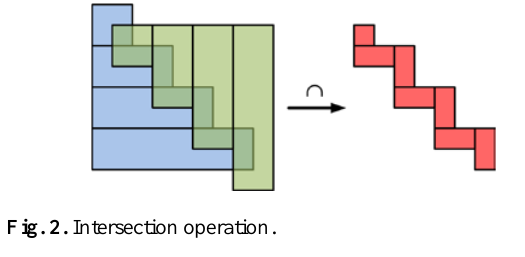
Fig. 2. Intersection operation .